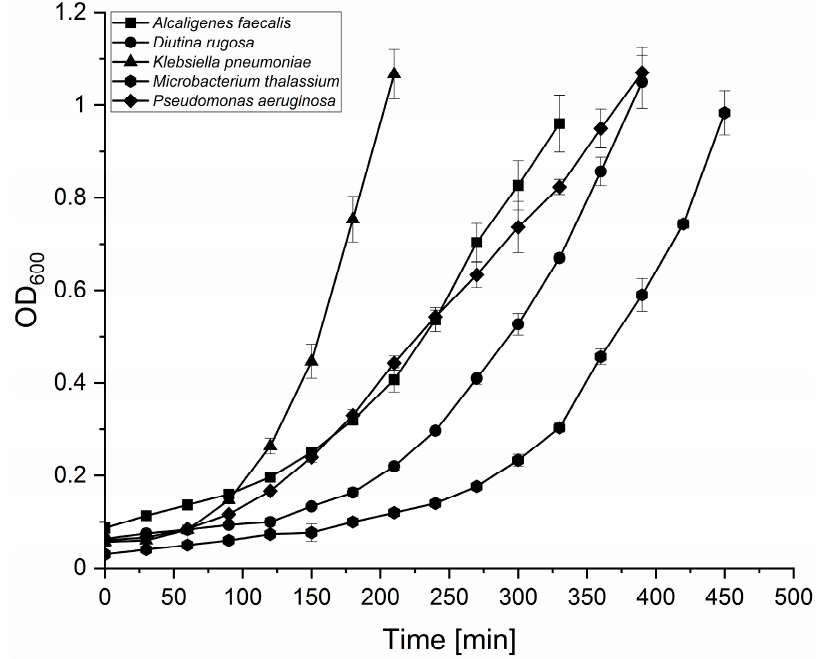
Figure 5. Growth curves of putative entomopathogenic bacterial ( A. faecalis , K. pneumoniae , M. thalassium , P. aeruginosa ) and yeast ( D. rugosa ) candidates. OD 600 was measured in 30 min intervals; the average optical density OD 600 ( ± SD) of three independent liquid cultures is shown.